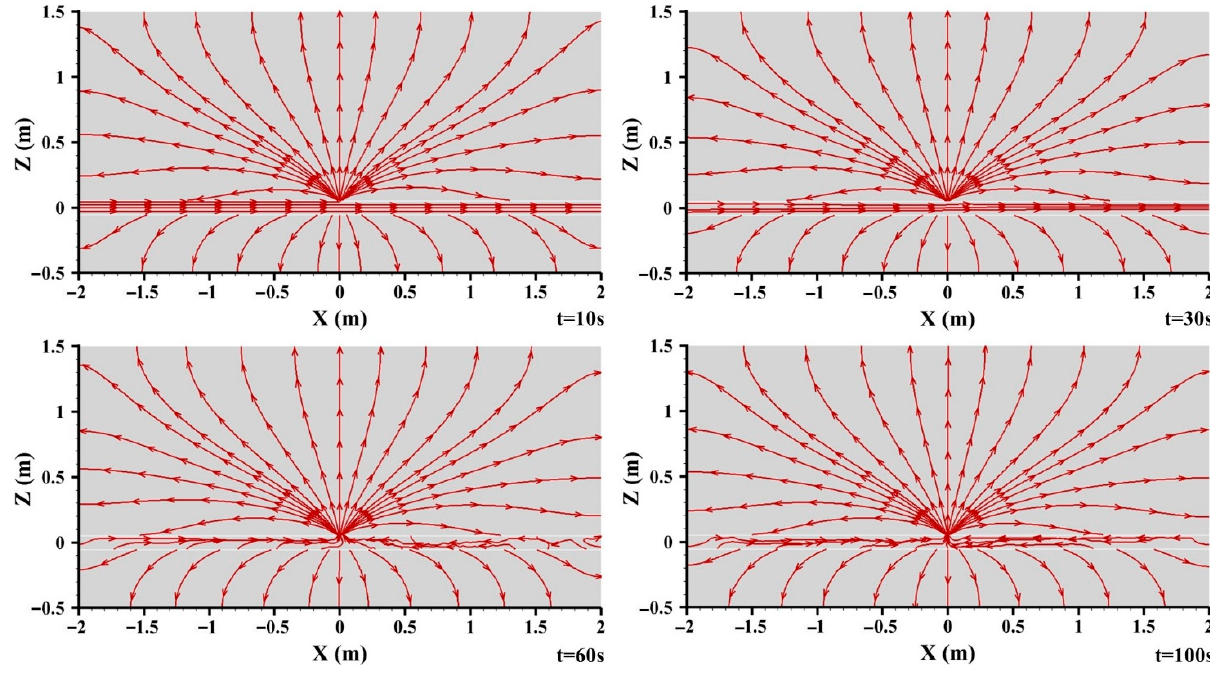
Figure 8. Cloud diagram of streamline distribution with different leakage time on plane Y = 0.